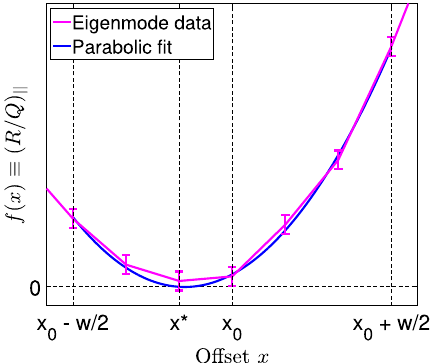
FIG. 2. Top: The considered example of a simple cavity (the vacuum region is shown in blue). The electric field of the chosen mode (TM210) is shown with arrows. Bottom: f ð x Þ ≡ ð R=Q Þ jj of the selected mode as a function of the horizontal coordinate x , with the black line given by the analytical formula and the purple crosses given by the eigenmode